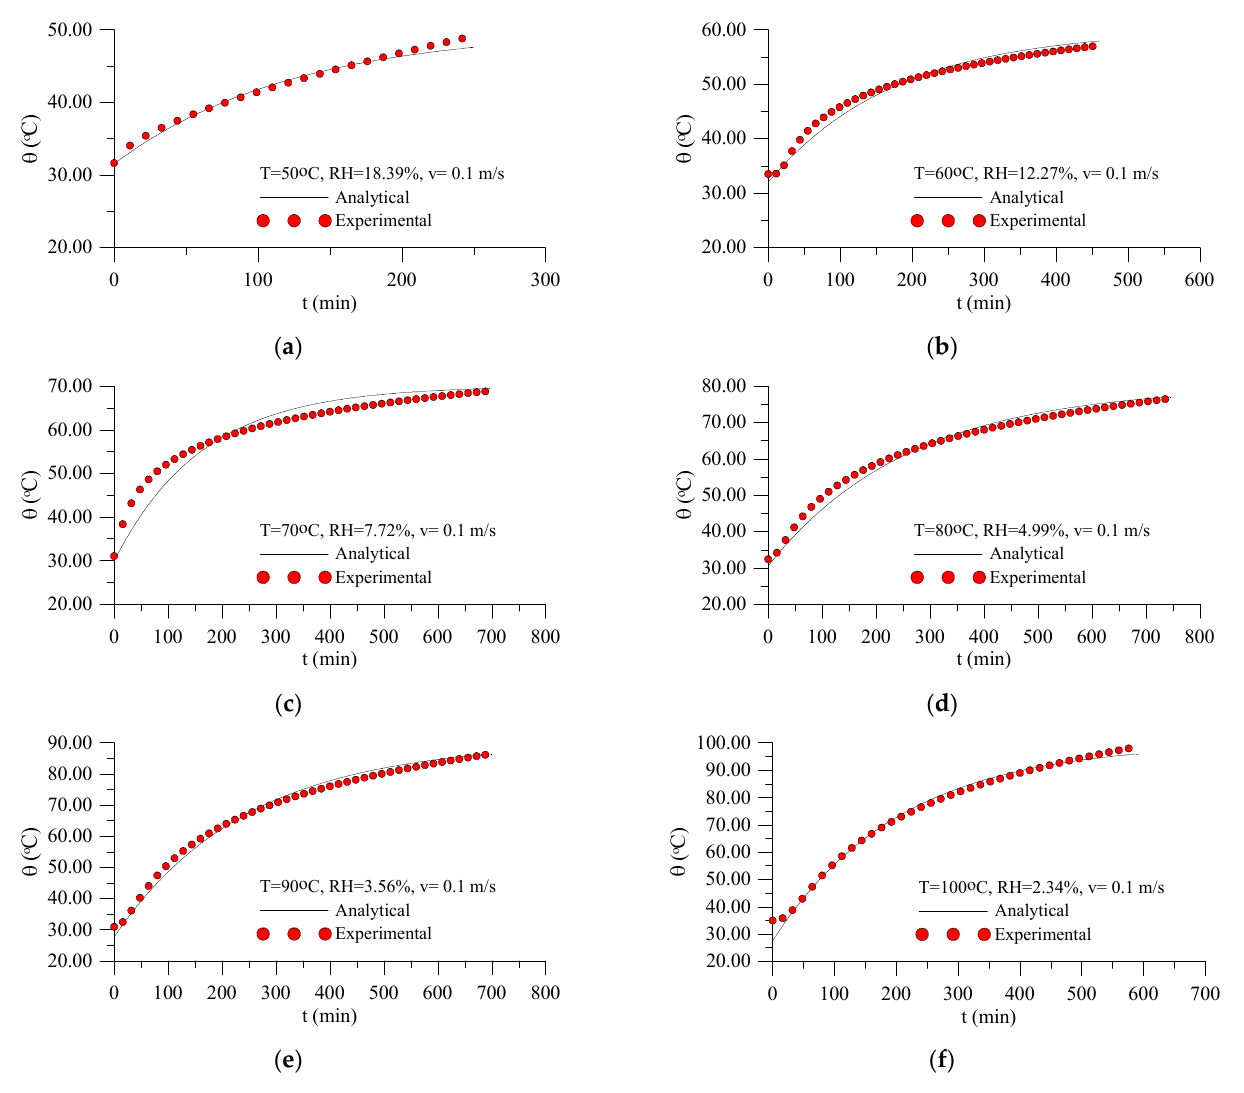
Figure 3. Transient behavior of experimental [14] and predicted temperatures of the ceramic block for different temperatures: ( a ) T = 50 °C, ( b ) T = 60 °C, ( c ) T = 70 °C, ( d ) T = 80 °C, ( e ) T = 90 °C, and ( f ) T = 100 °C.